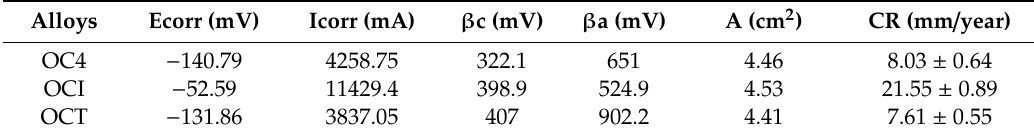
Figure 10. Tafel curves obtained from the LPR test for OCI, OC4, and OCT after 8 h of immersion in chloride molten salt at 720 °C. Table 7. Electrochemical parameters and corrosion rates obtained from the linear polarization resistance (LPR) test for the tested